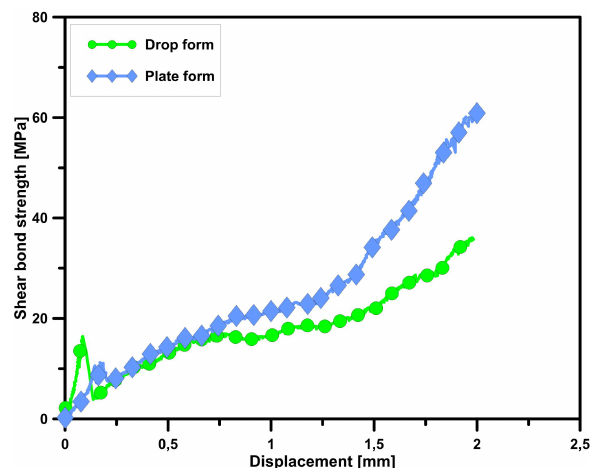
Figure 6: Example of shear bond strength results